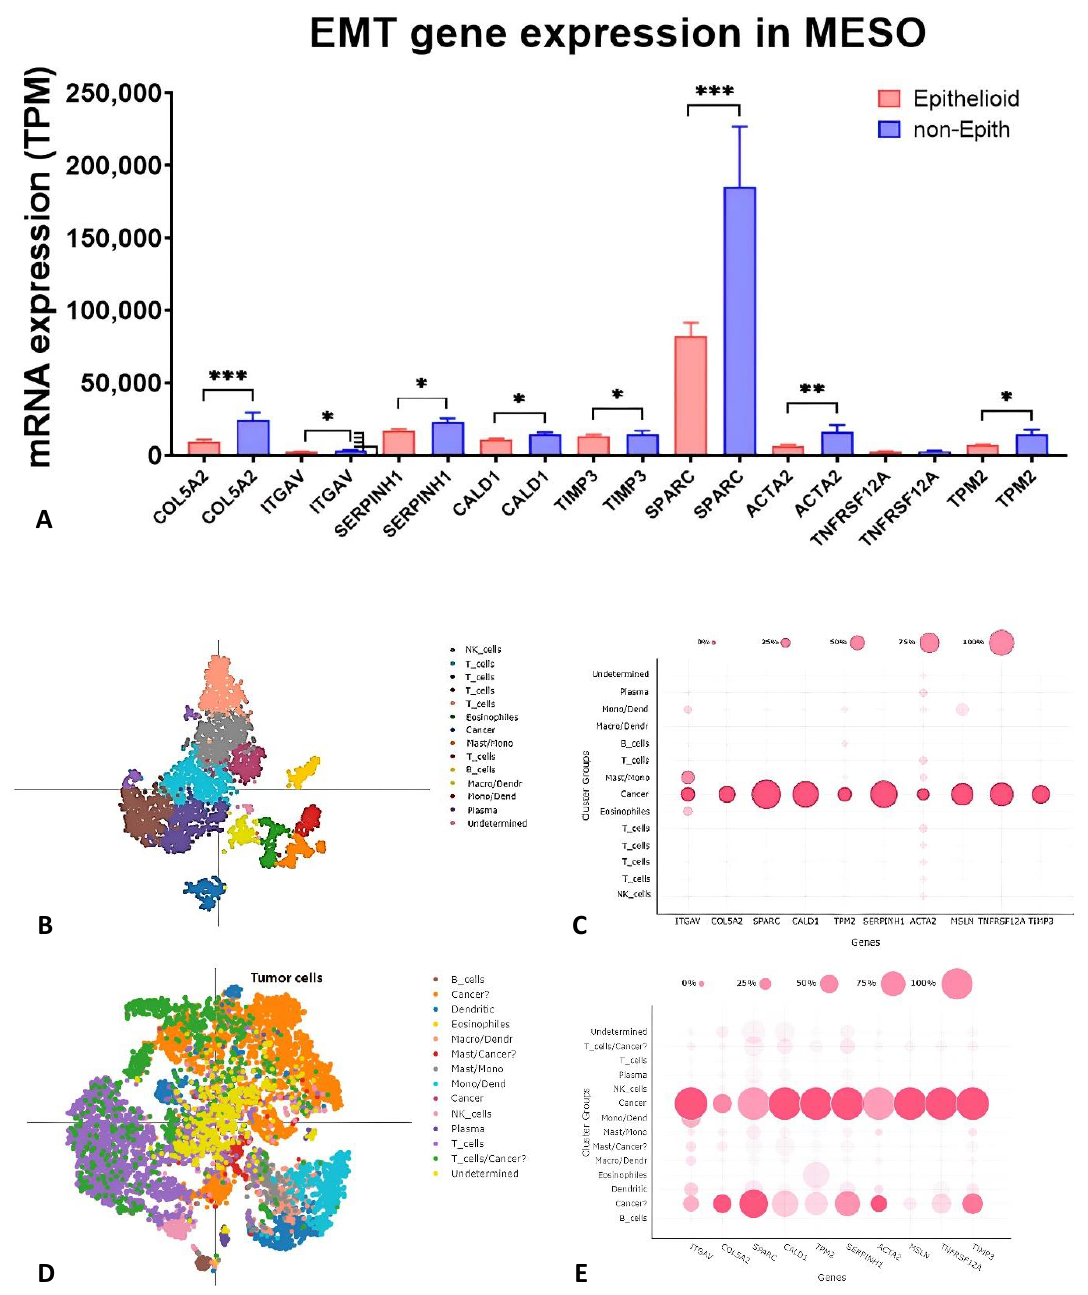
Figure 2. Gene expression of 9 EMT gene signature. ( A ) In the TCGA data set, the EMT gene expression was significantly higher in non-epithelioid MESO than epithelioid MESO. ( B , C ) scRNA- Seq results acquired from MESO patients with pleural effusion ( n = 3) and ( D , E ) biopsy tumor tissues ( n = 5). EMT genes were expressed predominantly on mesothelioma cells which were characterized by MSLN expression in both pleural effusion and biopsy tumor tissues. * p < 0.05, ** p < 0.01, *** p <